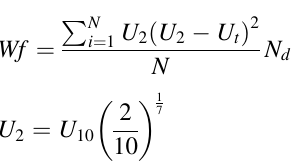
Fig. 1 Location of the study area, meteorological stations, deserts, and sandy lands in northern and western China. The study area is enclosed by a red contour line. Deserts and sandy lands are indicated by numbers: the Gurbantunggut Desert (1), the Taklimakan Desert (2), the Kumtag Desert (3), the Desert in Qaidam Basin (4), the Badain Jaran Desert (5), the Tengger Desert (6), the Ulan Buh Desert